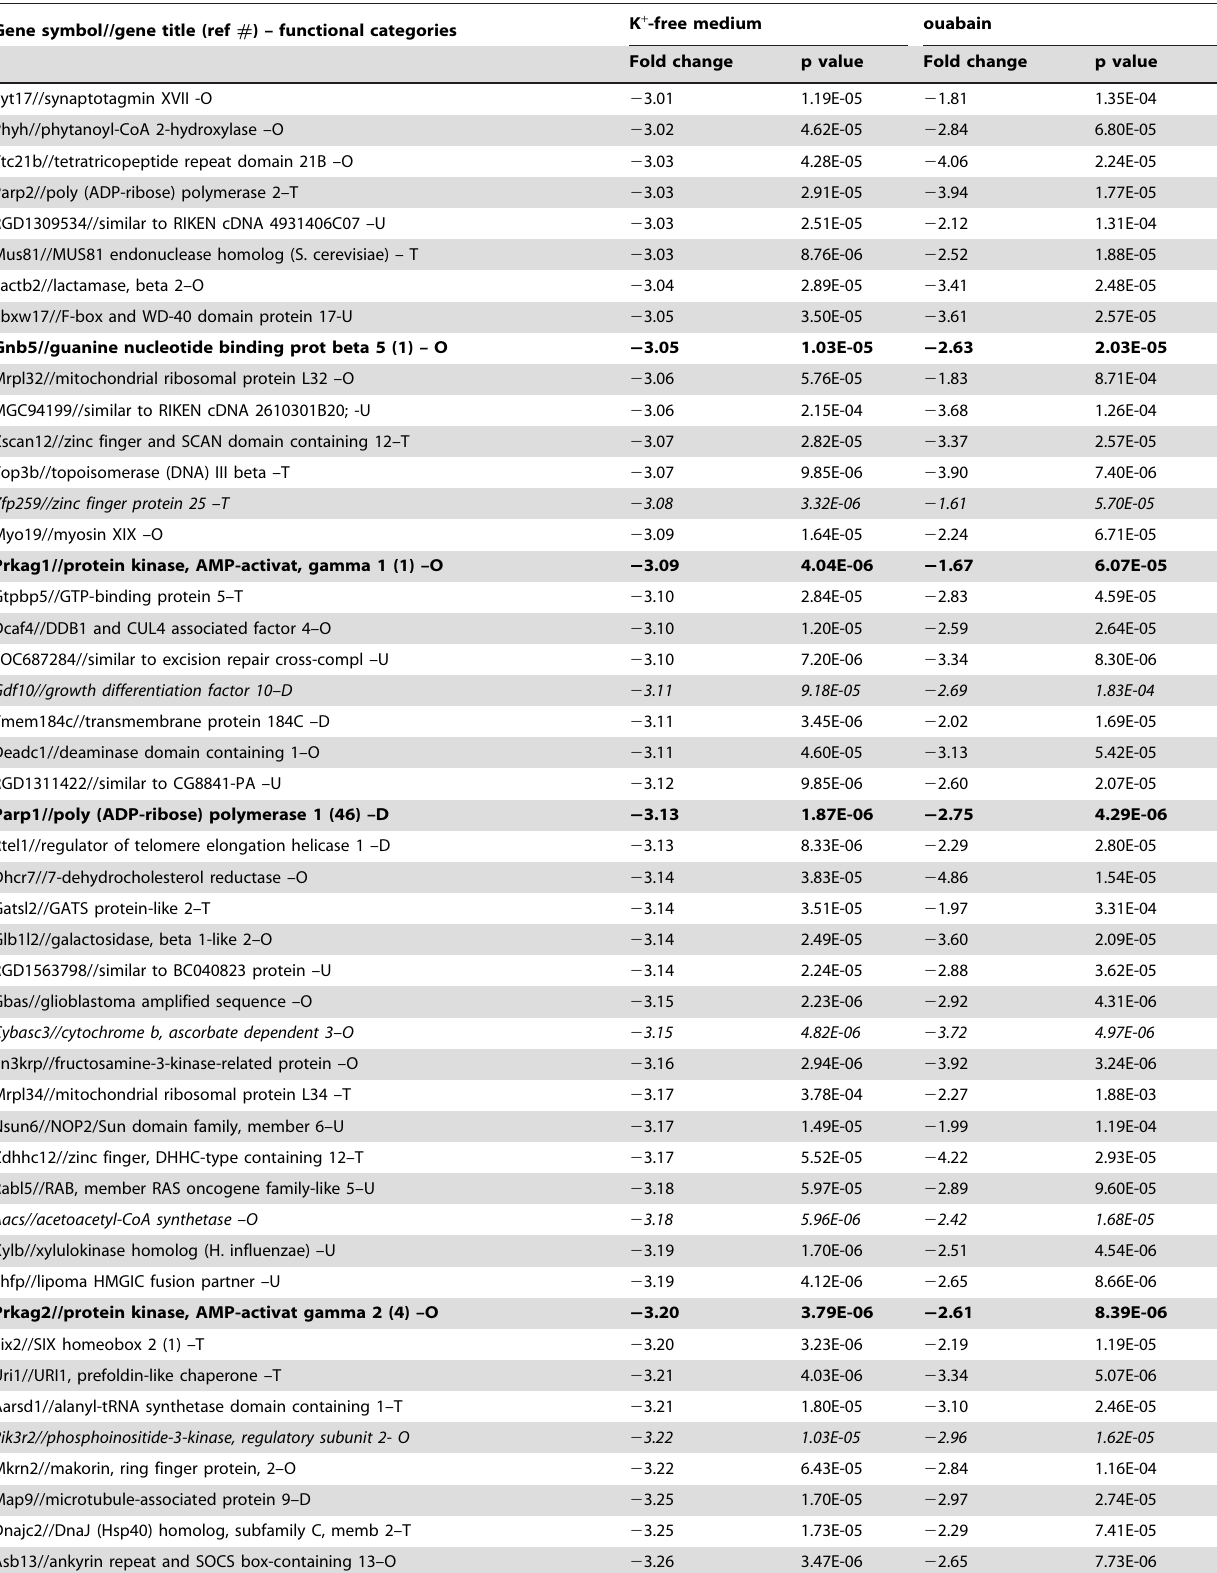
Gene symbol//gene title (ref # ) – functional